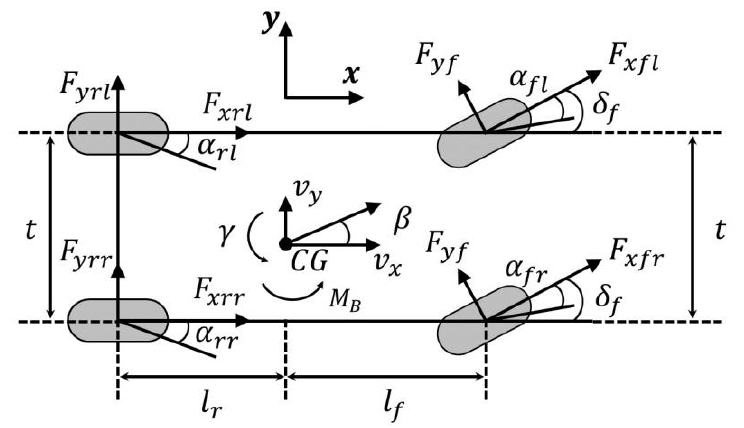
Figure 2. 7-DOF vehicle model.